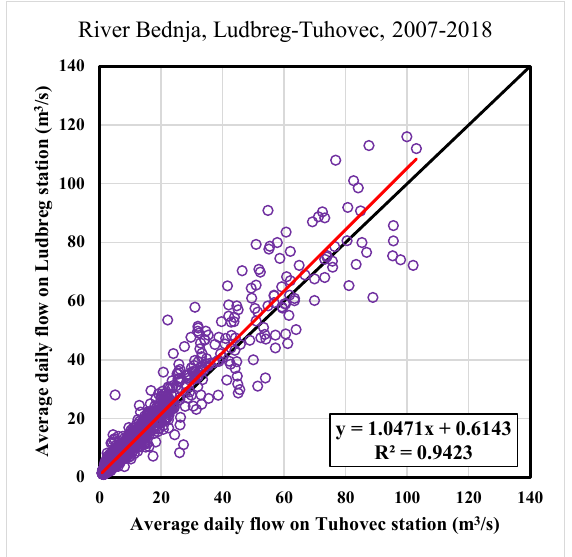
Figure 11. Comparison of the correlation between the measuring stations Ludbreg and Tuhovec. An overall perspective of the correlation between streamflow for the different moni- toring stations was provided based on the cross-correlation function XCF . After calculat- ing the cross-correlation between the other time series, the correlation peak was detected in intensity and lag time. The peak can be expressed as: where s is the size of the time series, equal to the monitoring period, and τ is the lag time [26].